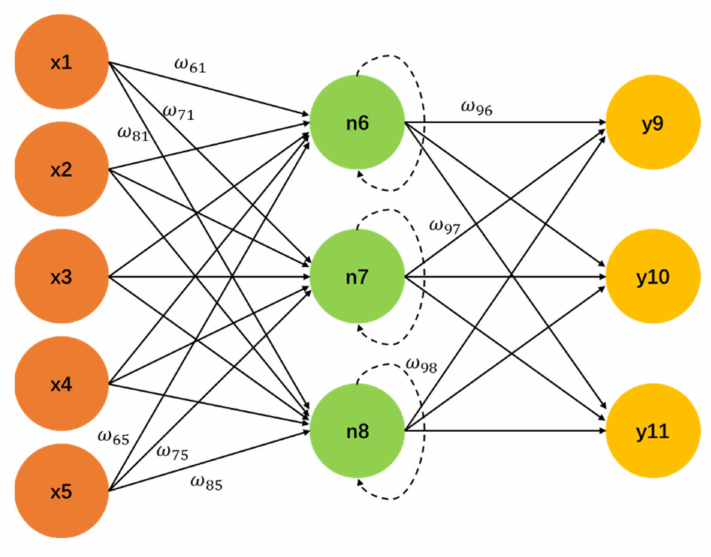
Figure 1. Structure diagram of the simple recurrent